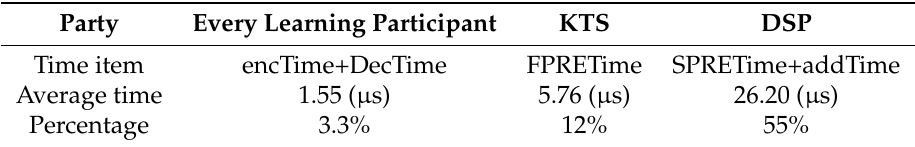
Table 4. Average computational cost of parties in our scheme.